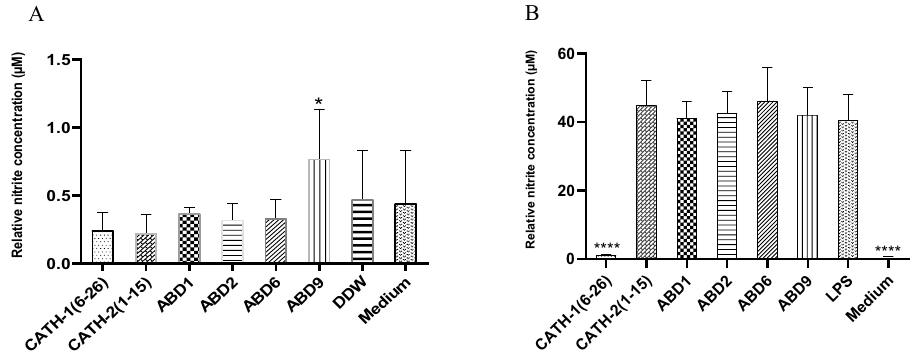
Figure 5. NO production and neutralisation of LPS-induced NO production using the Griess assay. ( A ) NO production by HD11 cells stimulated with 20 µg/ml each peptide after 24 h incubation. * means significantly different between the ABD9 treated and untreated groups (medium group) with p < 0.05. ( B ) Neutralization of LPS-induced NO production of HD11 cells by 20 µg/ml of AMPs post 24 h stimulation. **** means significantly different from the LPS-treated group ( p < 0.0001). One-way ANOVA analysis using the Dunnett post-hoc test was used. All data shown are obtained from at least three independent experiments on different days, means ± SD.